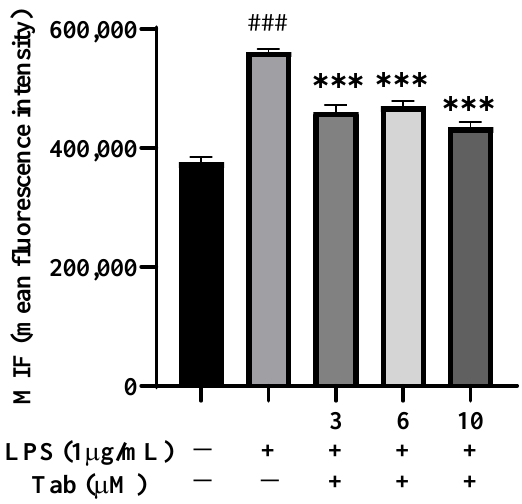
Figure 4. Effect of Tab on LPS-induced ROS in BV2 Cells. The cells were pretreated with Tab for 4 h, then treated with LPS (1 µ g/mL) for 24 h. Then quantitative analysis of DCFH-DA accumulation by FACS. ### p < 0.001 vs. untreated control cells and *** p < 0.001 vs. LPS-treated cells.